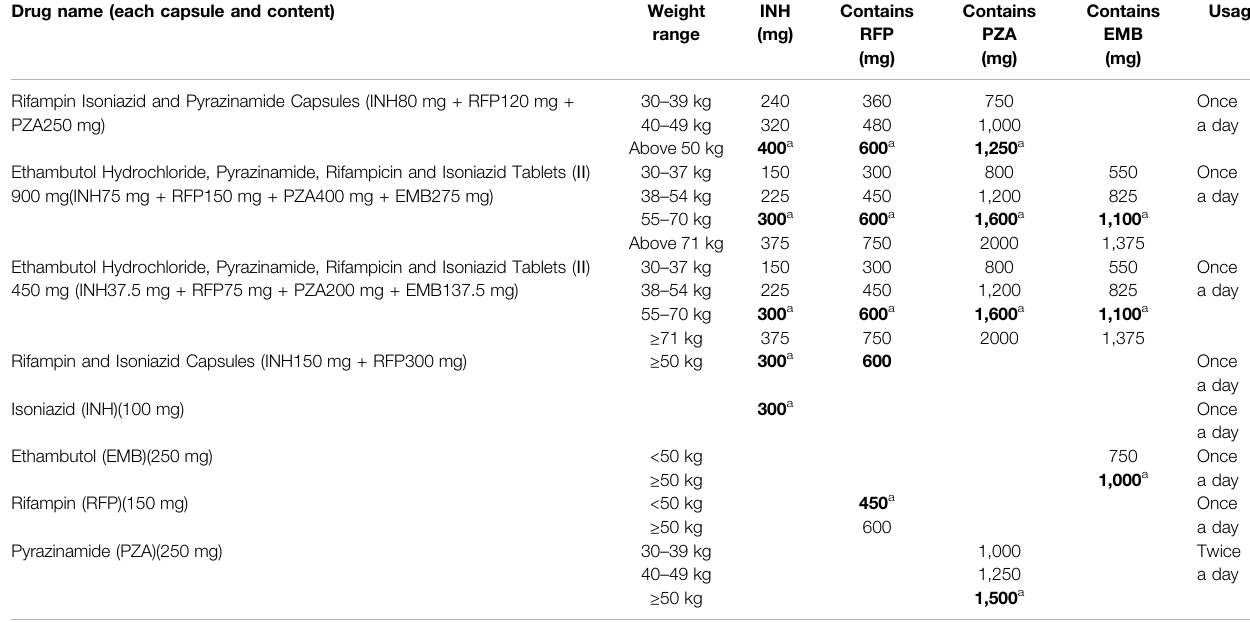
TABLE 1 | Dosage of fi rst-line anti-tuberculosis drugs for adults. Drug name (each capsule and content) Weight